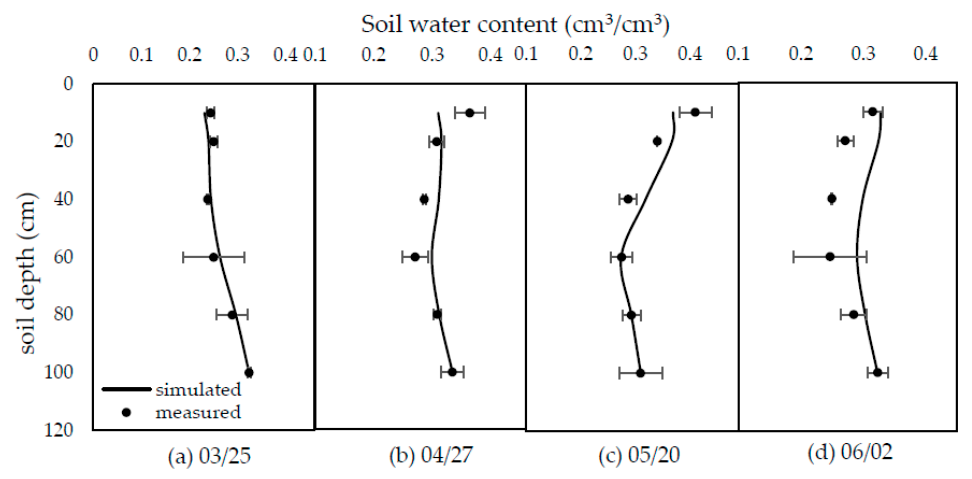
Figure 9. Comparison between simulated and measured soil water content of different soil layer in W4 treatment. ( a – d ) is March 25, April 27, May 20 and June 2,